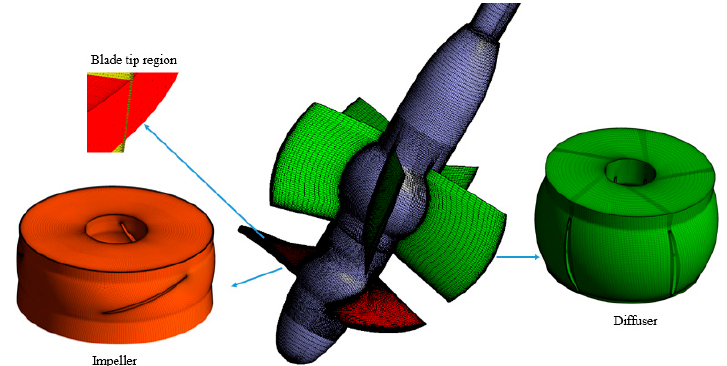
Figure 4. Grids of the main components of the axial-flow pump.